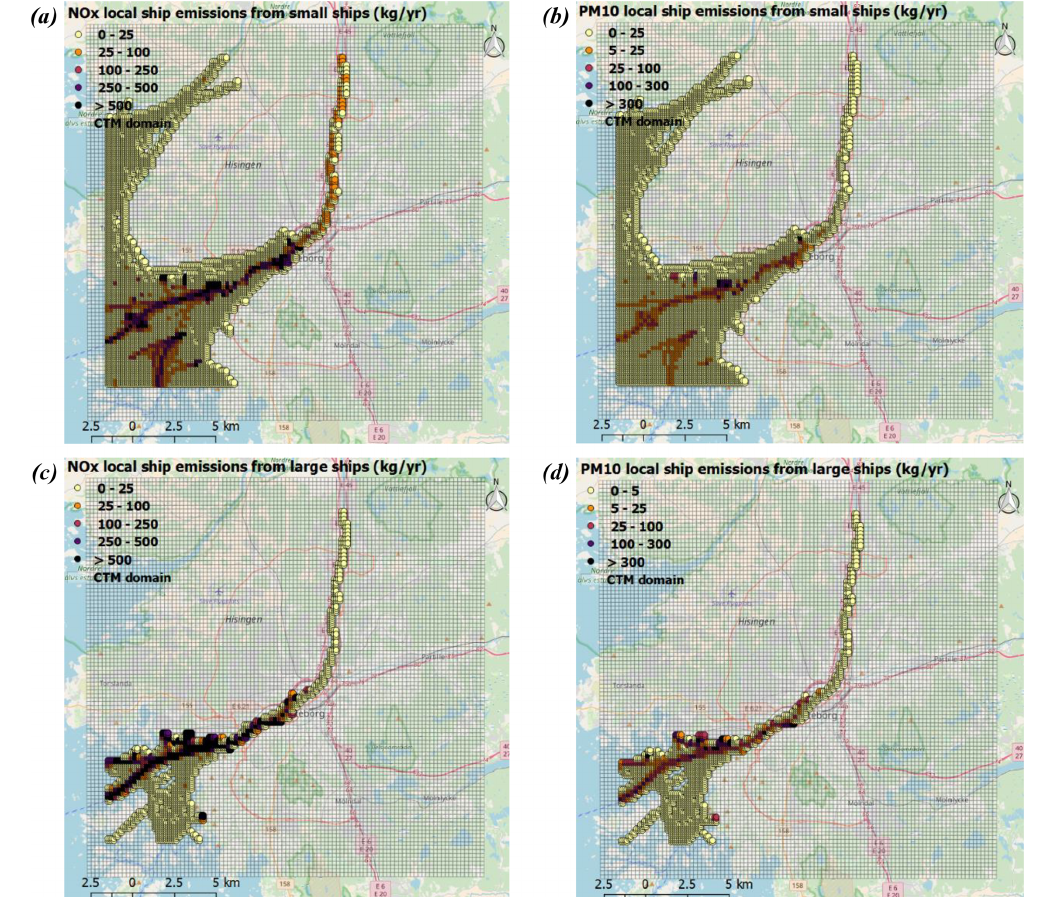
Figure 2. Annual local shipping emissions of (a) NO x and (b) PM 10 (equal to PM 2 . 5 ) from small vessels with a stack height below 36m (assumed 15m) and (c) NO x and (d) PM 10 from large vessels with high stack height above 36m (assumed 36m) in the Gothenburg